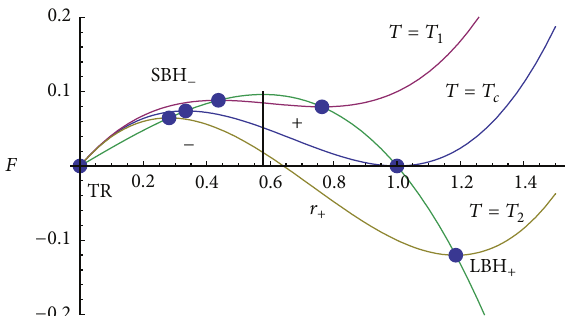
Figure 2: On-shell free energy 𝐹 on ADT (𝑚 2 = 1, 𝑀) = −𝑀/2 for the BTZ and 𝐹 TSOL ADT (𝑚 2 = 1) = −0.5 for TSOL with 𝐺 3 = 1/8 and ℓ = 1 . Three off-shell free energies for the BTZ are given by 𝐹 off ADT (𝑚 2 = = 1/3𝜋, 𝑇 = 1/2𝜋 , and 𝑇 = 2/3𝜋 . On the other 1, 𝑀, 𝑇) for 𝑇 = 𝑇 − 1 𝑐 2 hand, the off-shell free energy for TSOL is 𝐹 off TSOL . They are connected at the point of 𝑀 = 0 . Here, the MBTZ located at 𝑀 = 0 plays a role of the mediator like SBH −